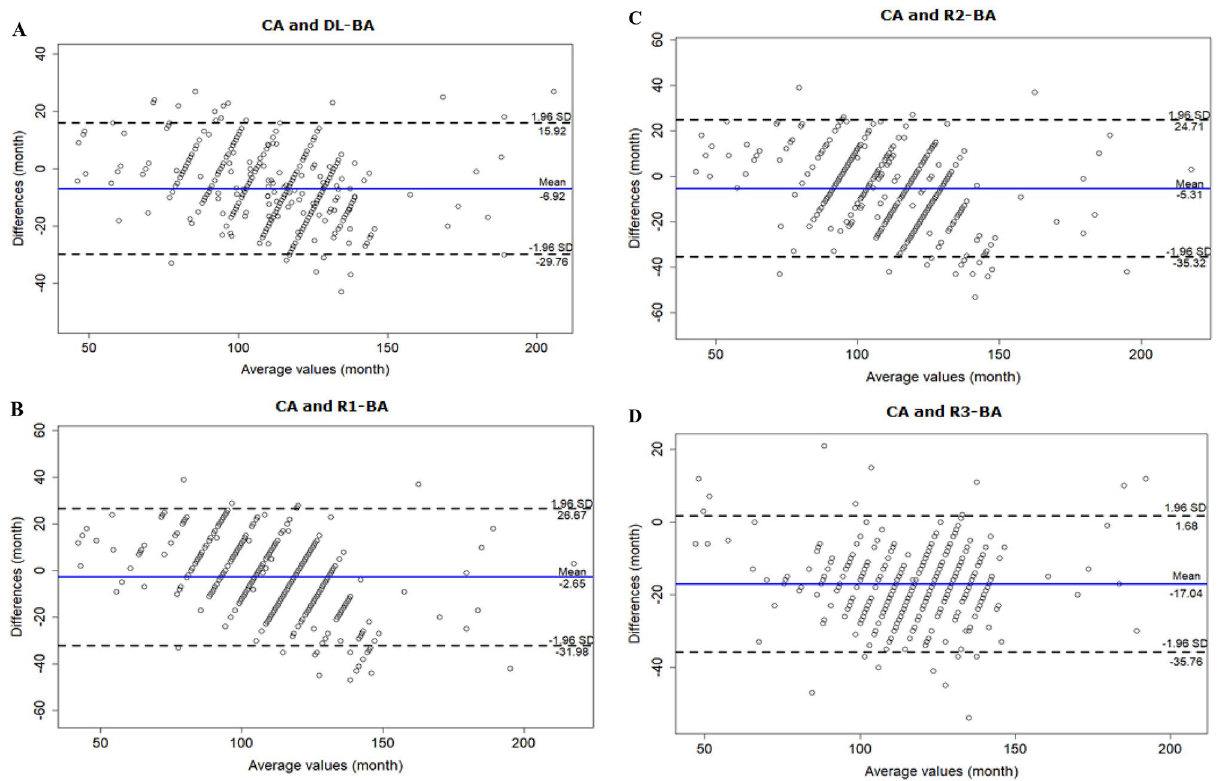
Figure 4. Bland–Altman plots for CA vs. DL and each reviewer-estimated BA. ( A ) Bland–Altman plot for CA and DL-estimated BA demonstrates DL’s tendency to overestimate BA, especially of children over the age of 120 months. ( B ) Bland–Altman plot for CA and R1-BA demonstrates R1’s tendency to overestimate BA, especially of children over the age of 110 months. ( C ) Bland–Altman plot for CA and R2-BA demonstrates R2’s tendency to overestimate BA, especially of children over the age of 110 months. ( D ) Bland–Altman plot for CA and R3-BA demonstrates R3’s tendency to overestimate BA, regardless of children’s